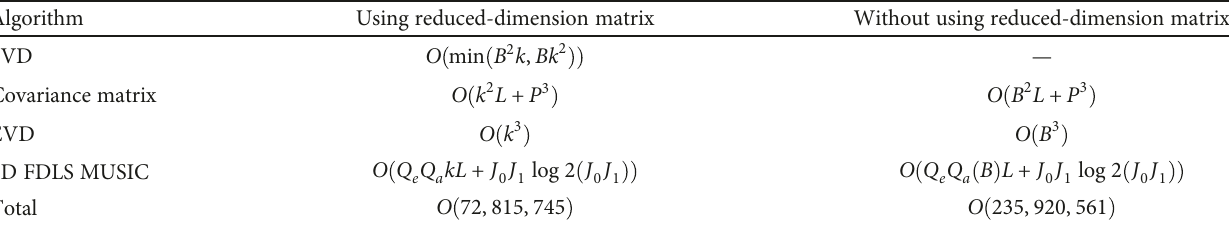
Table 1: Computational complexity.